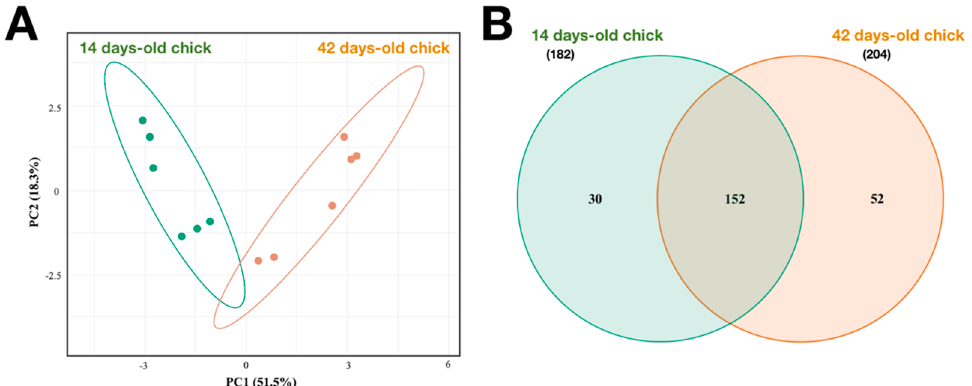
Figure 2. Principal component analysis (PCoA) and Venn diagram summarising differential microbiota community in caecal samples across 14 and 42 days of rearing cycle. ( A ) Evaluation of the beta diversity based on Bray–Curtis dissimilarity between growing stages (14- and 42-day-old chicks) represented by a PCoA graphic. ( B ) Venn diagrams showing the distribution of shared and unique sequences assigned at the genus level among the different growing stages (14- and 42-day-old chicks).